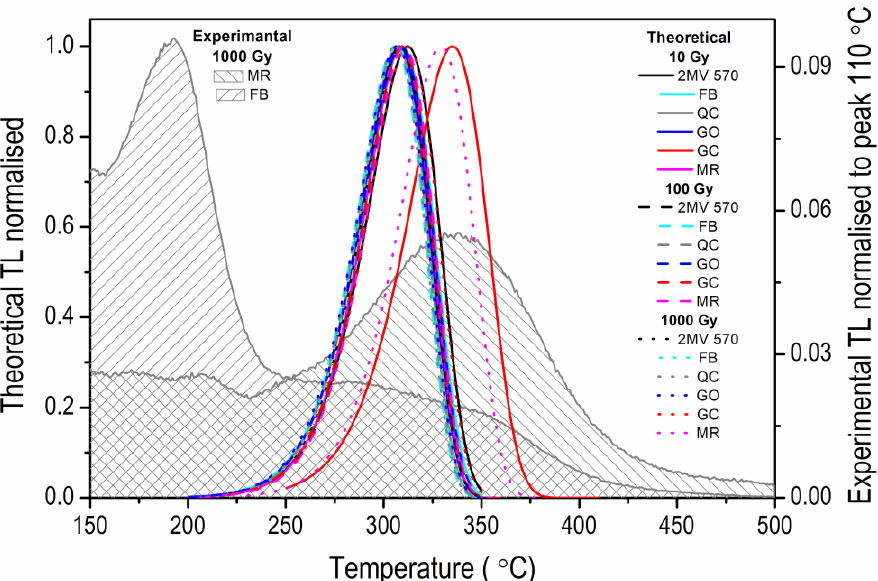
Figure 8. The theoretical single first-order kinetic TL peaks calculated for trap parameters E and s obtained in OTDC experiments set in Table 2 according to Equation (4) (left vertical axis), heating rate of 2 Ks −1 . Experimental TL curves (area filled with grey lines) measured using heating rate of 2 Ks −1 for MR and FB samples after irradiation with a dose of 1000 Gy and normalisation to peak 110 °C (right vertical axis) — the same data as shown in Figure 1.